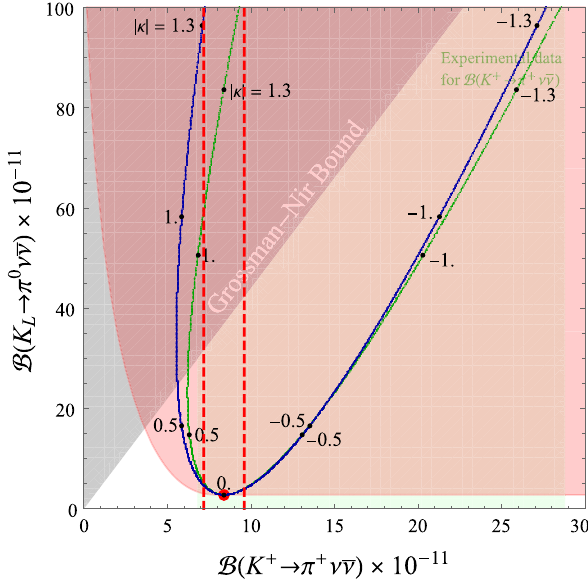
Fig. 4 Rates covered by Eq. 14 are illustrated in pink along with the BNLresultingreenandtheGNexclusioningrey.TheSMcentralvalues areshownasthelargereddotandthedashedverticallinescorrespondto ± 3 σ from the central SM value of B φ κ = 43 ◦ K + . The green curve for and the blue curve for φ κ = 38 ◦ are chosen to illustrate values that can ∼ 10 − 9 while keeping B produce B K K + near its SM L